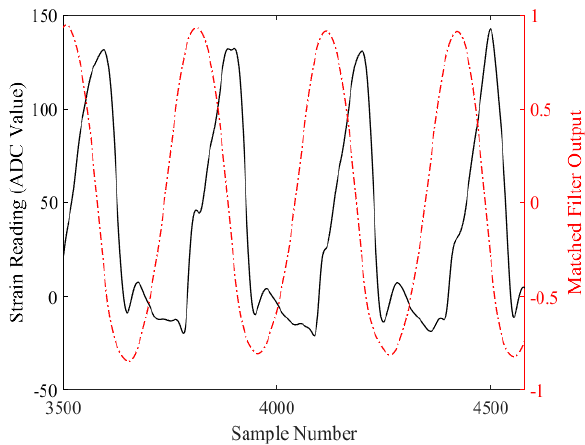
Figure 4. The matched filter output (dotted red line) obtained when correlating the template signal with unknown strain gauge data (solid black line).